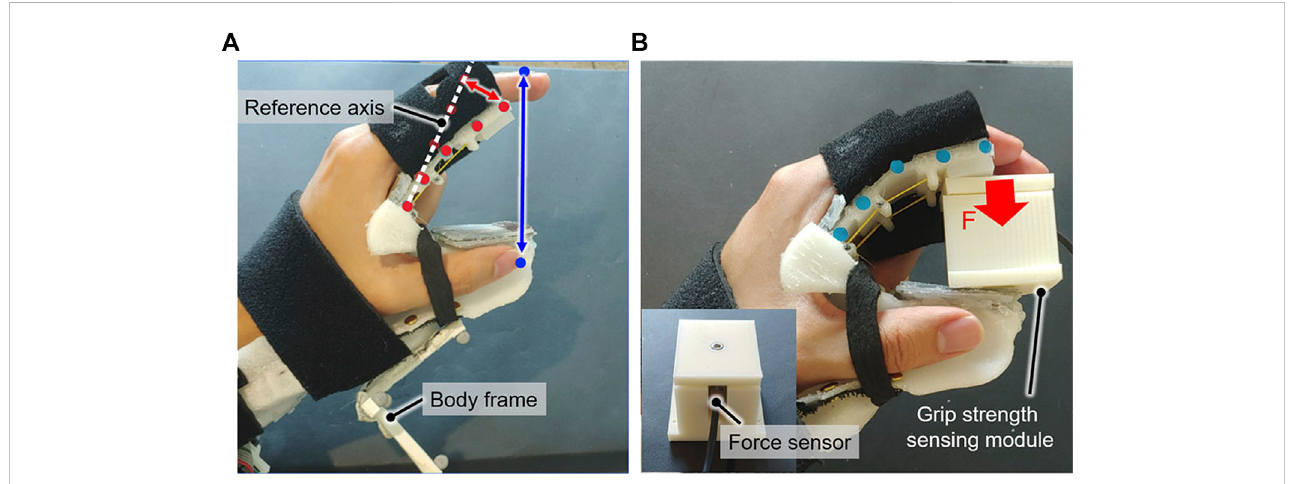
FIGURE 7 Experimental setup for evaluating the orthosis. (A) The beam de fl ection at the tip (red arrow) and grip aperture (blue arrow) were measured by tracking re fl ective markers, which were attached to the upward-facing side of the beam (red dot) and fi ngertips (blue dot). The beam de fl ection was measured with respecttothereferenceaxis,whichwasdeterminedbasedonthemarkerspriortotheorthosisbeingworn. (B) Thegripstrengthoftheorthosiswasmeasured using a grip strength – sensing module under an applied assistive